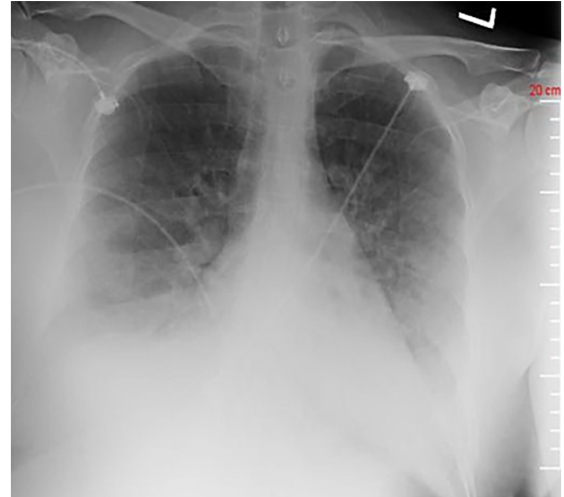
Image 1. Anterior-posterior chest radiograph demonstrating findings consistent with fluid